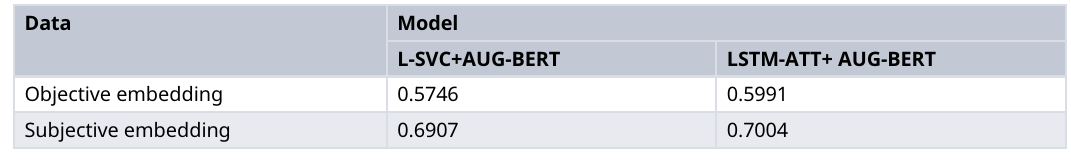
Table 2. Accuracy of two classifiers with augmentation technique.